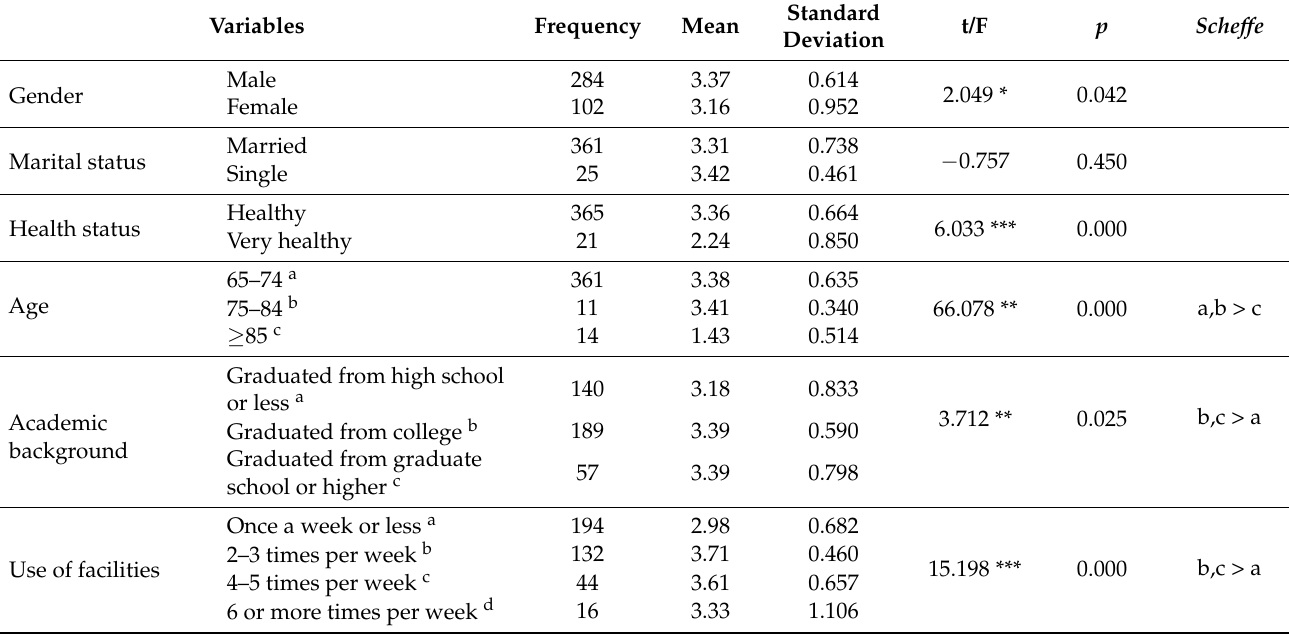
Table 6. Differences in user satisfaction according to demographic characteristics.